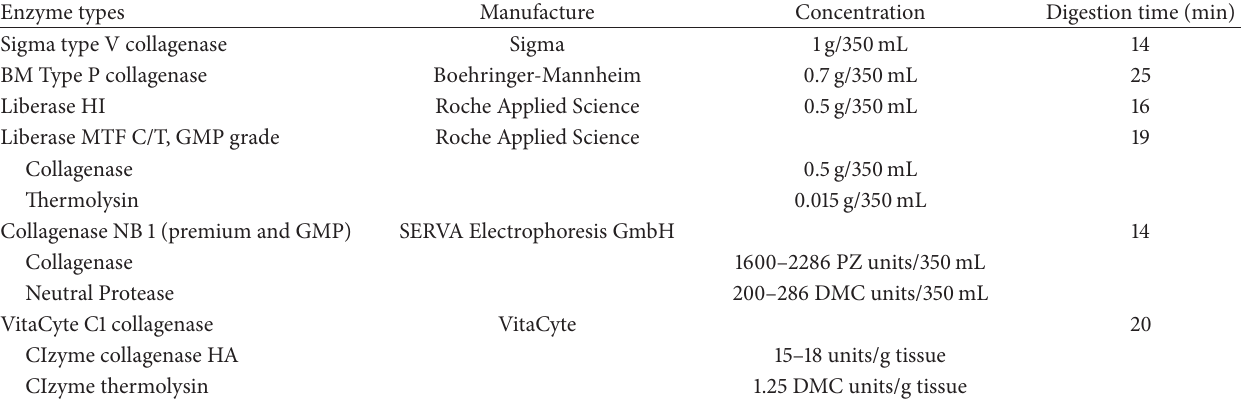
Table 1: Enzyme types used for human islet isolation.